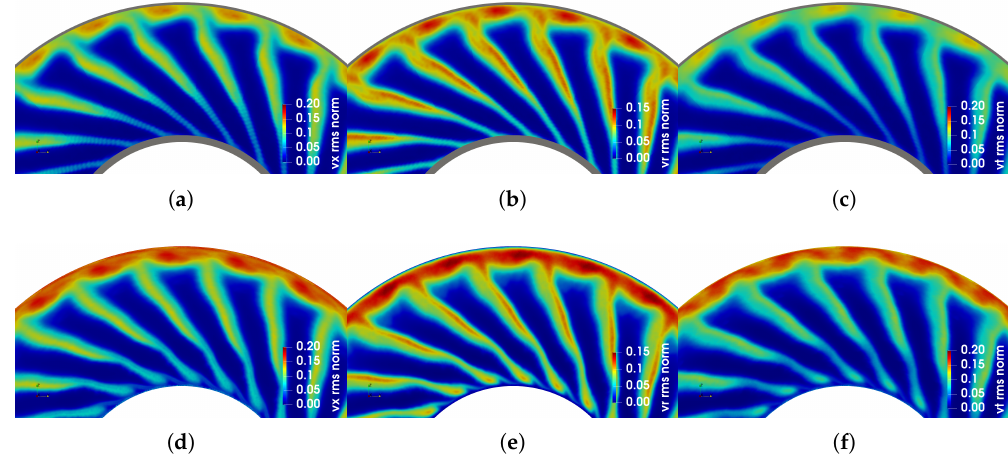
Figure 5. Normalized RMS velocity contours (view from downstream): ( a , d ) axial; ( b , e ) radial; ( c , f ) tangential. ( a – c ) Experimental data (the grey parts show the surface not covered by HWA). ( d – f ) LES